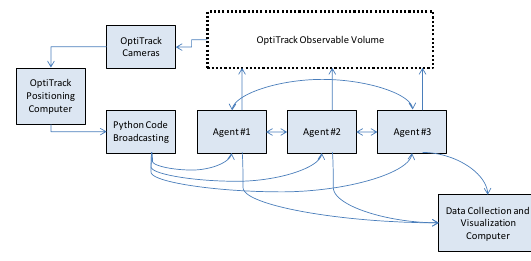
Fig. 10. Multi-robot testbed shared information flow.